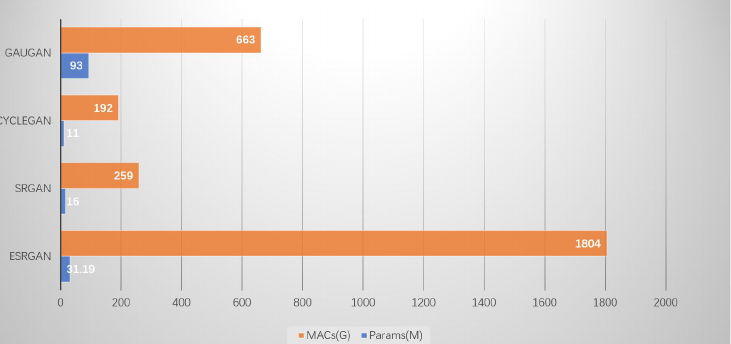
Figure 1. The model size and calculation amount of super-resolution using deep